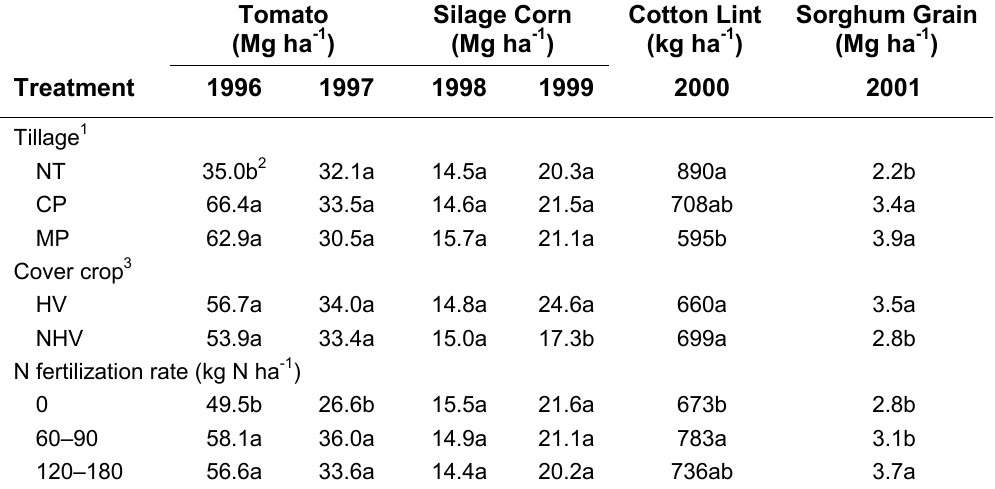
Effects of Tillage, Cover Crop, and N Fertilization Rates on Yields of Fresh-Market Tomato, Silage Corn (Dry Matter Weight), Cotton Lint, and Sorghum Grain[22] Tomato